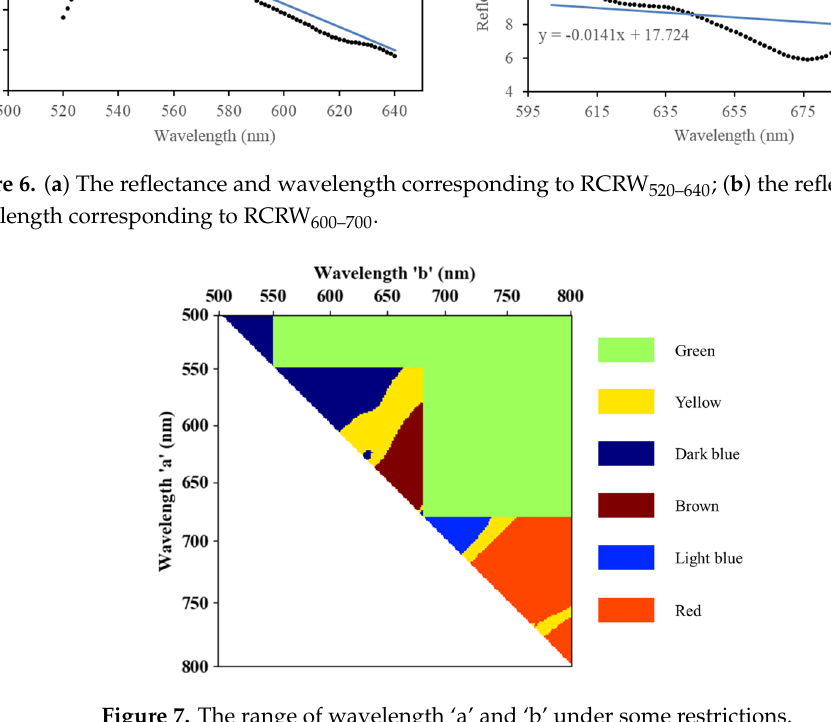
Figure 9. Scatter plots between ( a ) SPAD and RCRW 551.0–565.6 , ( b ) SPAD and RCRW 739.5–743.5 , ( c ) SPAD and RCRW 684.4–687.1 , ( d ) SPAD and RCRW 667.9–672.0 . 4.2. Model Configuration and Training In this study, the random stratified sampling method was used to divide the dataset into a training set (80%) and a validation set (20%). In addition, a fixed seed of random numbers was used to make the training dataset and validation dataset of all generated models fixed. The statistical characteristics of the dataset are shown in Figure 10. As can be seen in Figure 10, some statistical characteristics such as, mean (36.94 and 36.78), max (46.00 and 46.80), min (23.7 and 20.6), standard deviation (5.81 and 5.97), and coefficient of variation (0.157 and 0.162), of the validation set and training set are close. Moreover, the data distribution of the training and validation set, a significant